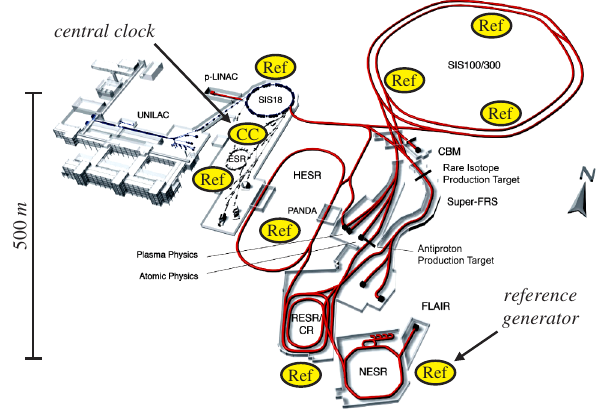
FIG. 1. (Color) Facility for Antiproton and Ion